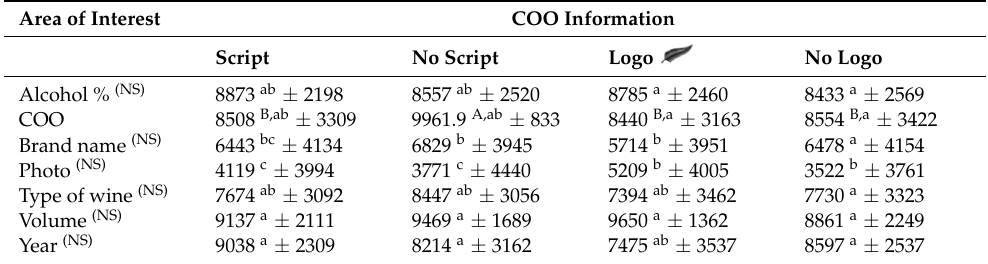
Table 1. Means and standard deviations of the time to first fixation (ms) on each AOI for four labels *. Area of Interest